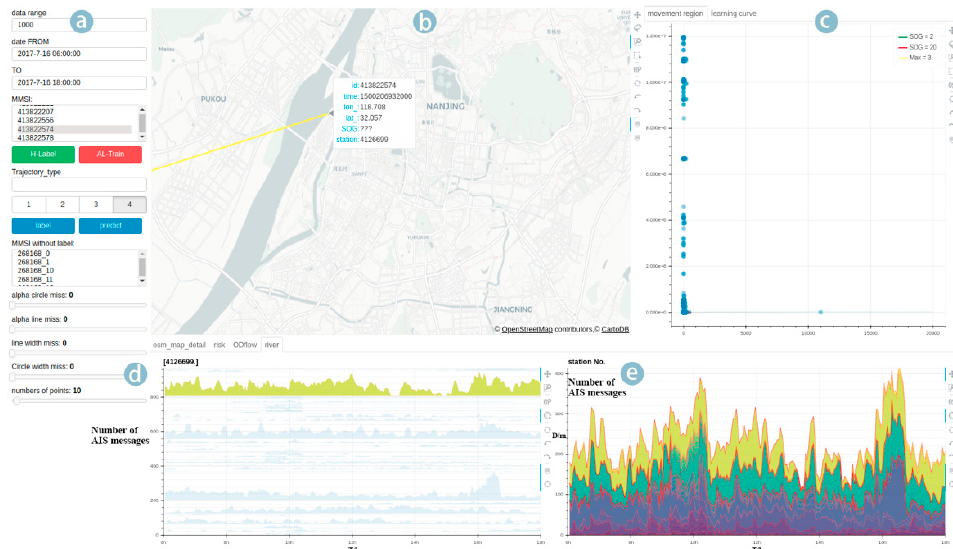
Figure 1. User interface of automatic identification system (AIS) Data Quality visualization (ADQvis). The interface design of ADQvis (Figure 1a) included an AIS time filtering tool in the form of a calendar table. The overall distribution of ship’s